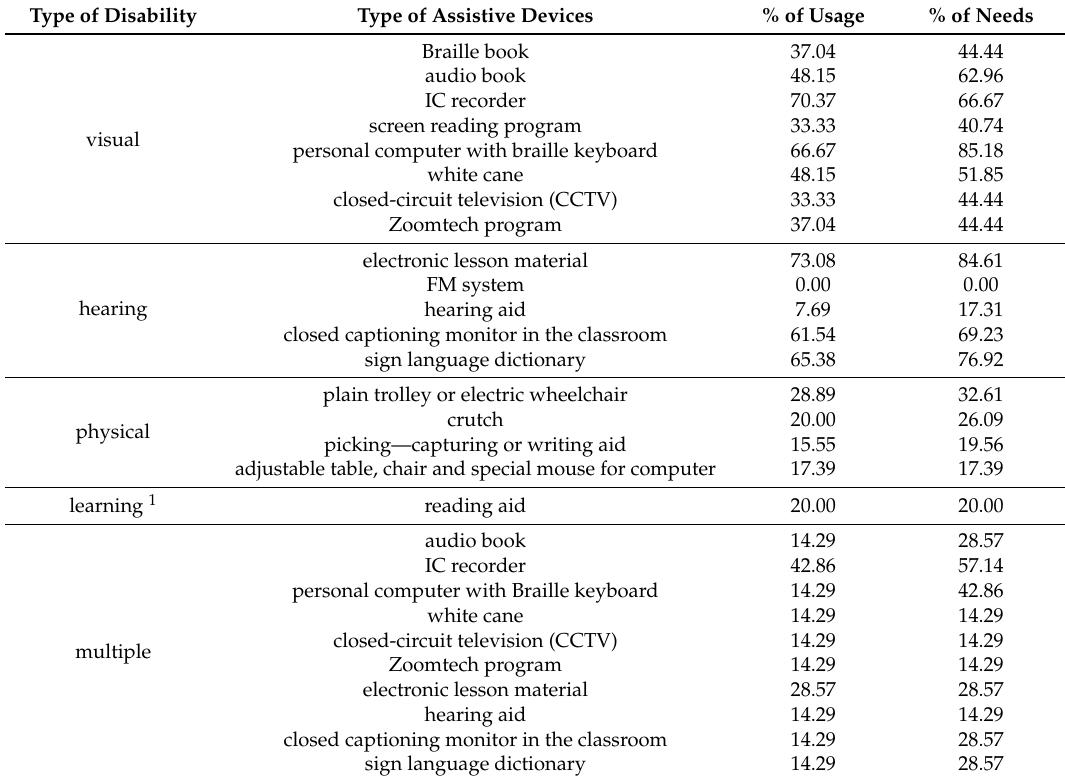
Table 3. Usage and needs of assistive devices for students with disabilities based on the universal design